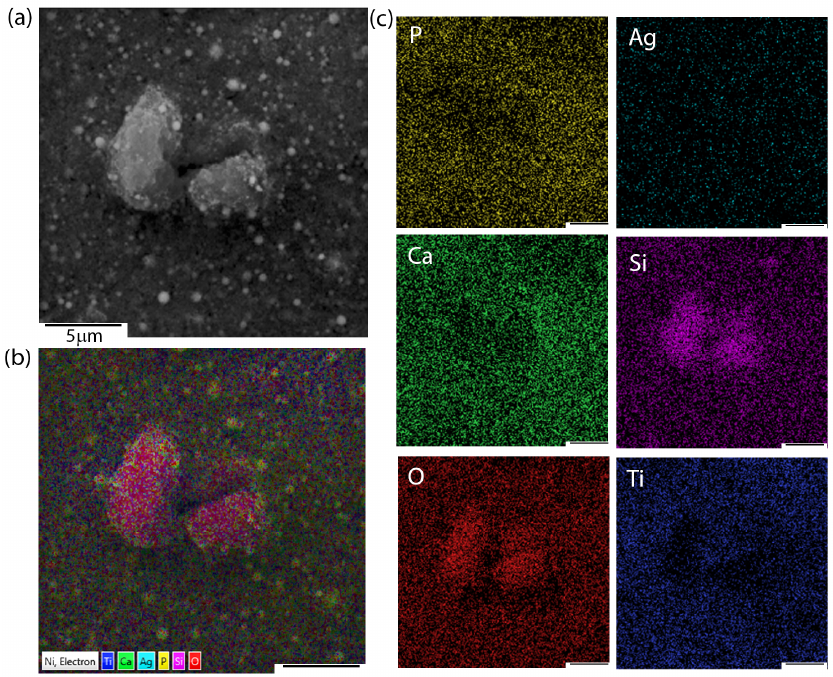
Figure 2. SEM image of 5:1 coating ( a ), multi-layer elemental distribution ( b ) and chemical composition imaging of elements ( c ).